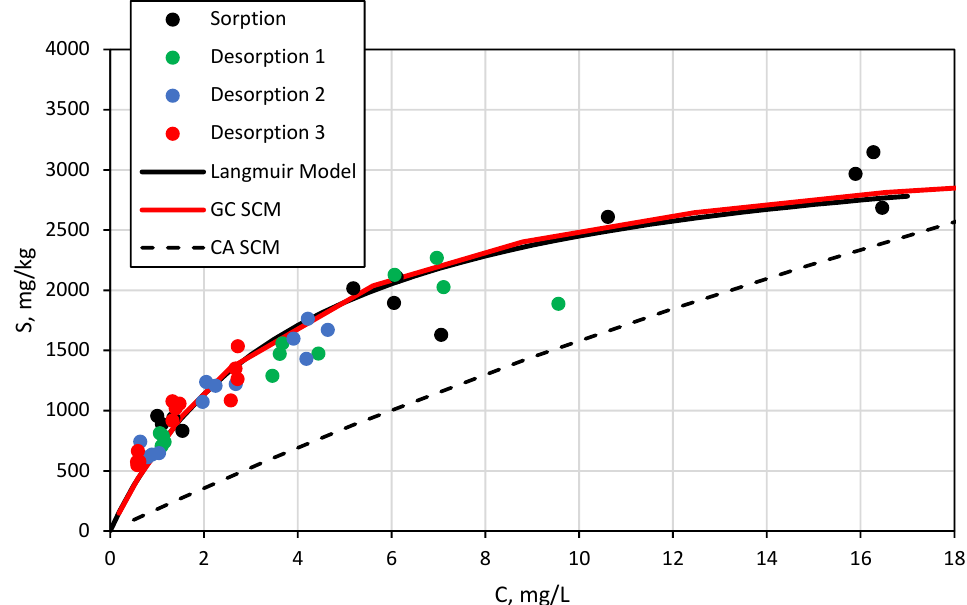
Figure 1. Sorption and desorption results for the HOP-5 phosphorite. Green, blue, and red colored full circles represent results for desorption steps 1, 2, and 3, respectively. Black full circles represent the sorption data. Solid curves show GC SCM (red) and Langmuir isotherm (black) fits to the data, and the dashed black curve is the CA SCM prediction discussed in Section 4.1.